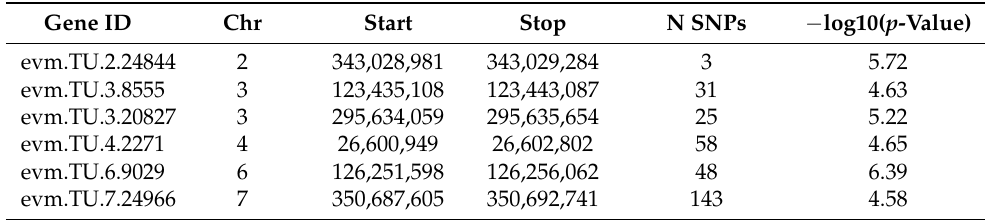
Table 4. Genes associated with CRR identified using MAGMA ( − log 10 ( p -value) > 4.0). Chromosome number (Chr); Gene coordinate (bp) on the chromosome (Start and Stop); numbers of SNPs detected within the gene sequence (N SNP); p -value for the association of the genes with the CRR ( p -value). Gene ID Chr Start Stop N SNPs − log10( p